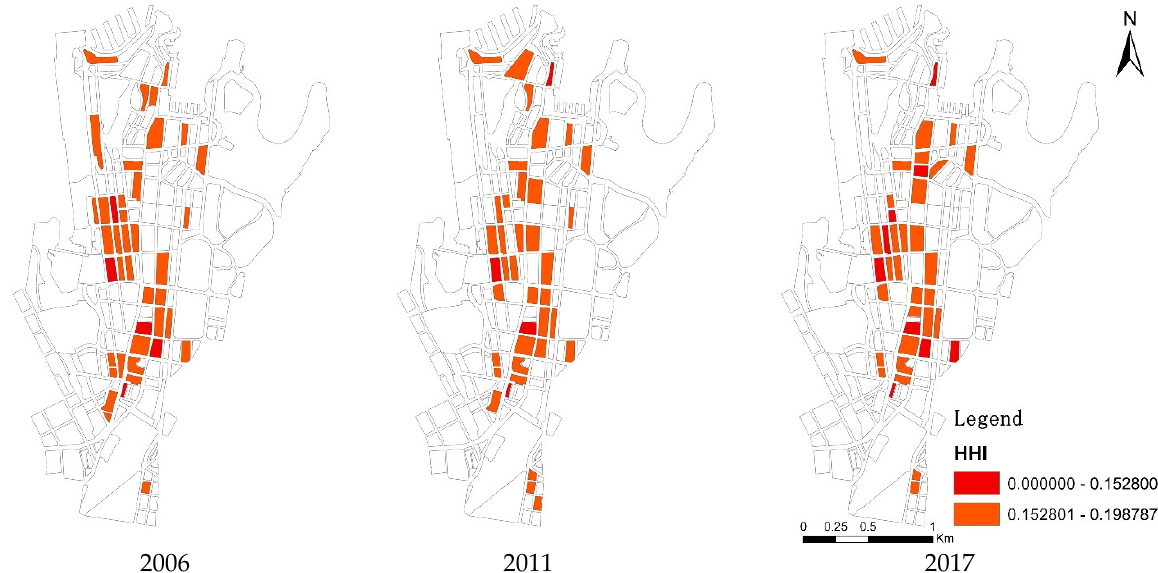
Figure 3. Time–series analysis: economic heterogeneity of urban blocks, calculated using Herfindahl-Hirschman index (HHI).